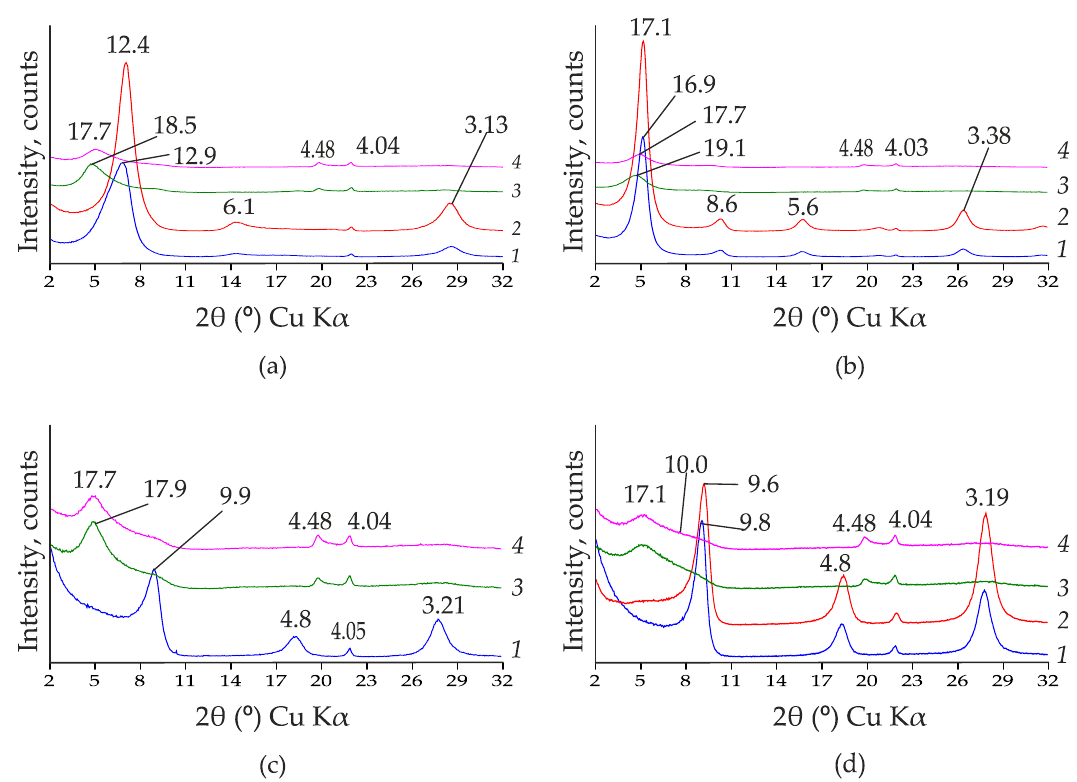
Figure 1. XRD patterns of the Ca-, Na-, HAl 13 - and Al 13 -bentonite, <1 µm fraction (1, 2, 3 and 4, respectively) in the air-dry state ( a ), ethylene glycol (EG)-solvated ( b ), calcined at 350 °C ( c ) and 550 °C ( d ). The d(001)-values are given in Å.